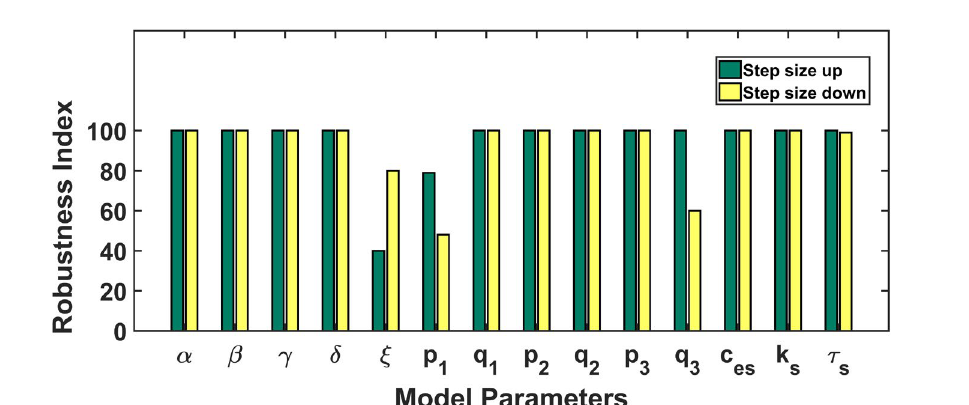
Figure 4. Robustness analysis: the figure shows the dependence of the model’s dynamics on parameter variations. Parameters were varied 100% up down from the baseline values. The length of bars represents the range of parameters up to which the model dynamics hold despite parameter variation. The green color bar represents the robustness result achieved by increasing the parameter value and the yellow color for the opposite case